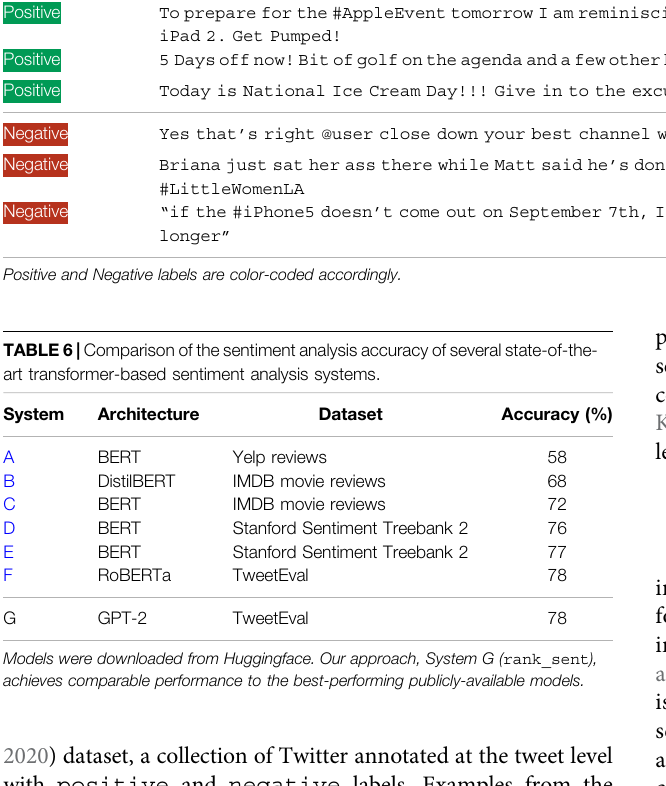
TABLE 5 | Examples from the TweetEval (Rosenthal et al., 2017; Barbieri et al., 2020) dataset. Sentiment Tweet